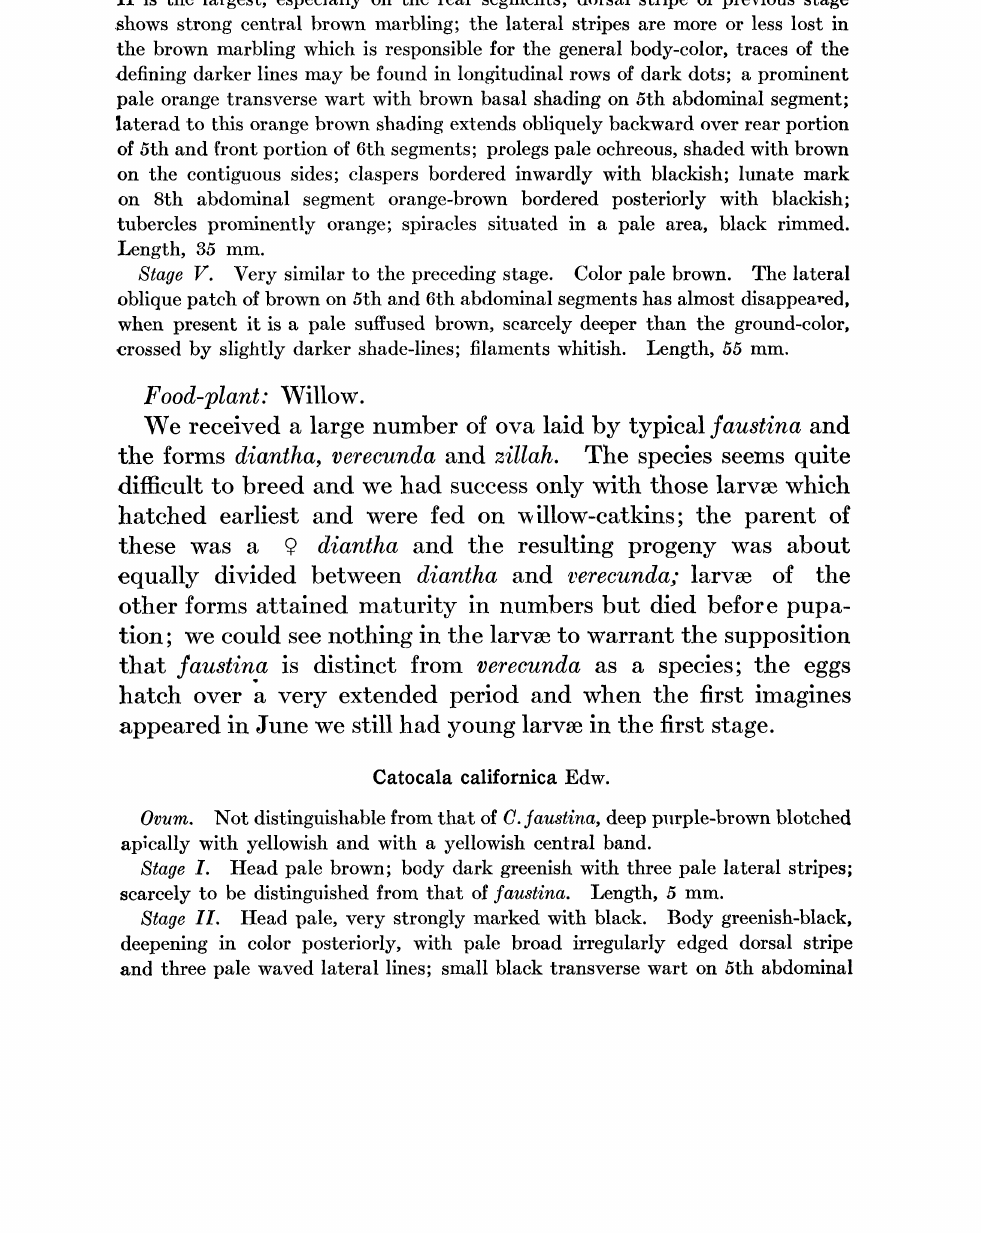
segment with slight central reddish portion; lateral black shading on 5th and 6th abdominal segments extending down over prolegs; a black lunate mark on rear of 8th segment dorsally; tubercles red-brown. Beneath whitish with black patches. Length, 0 mm. Stage IV. Head pale, apex of lobes orange, this color extending downward to the region of the ocelli, the whole frontal area bordered by an encircling black band. Body smooth, slender, pale purple-brown with orange tubercles of which II is the largest, especially on the rear segments; dorsal stripe of previous stage .shows strong central brown marbling; the lateral stripes are more or less lost in the brown marbling which is responsible for the general body-color, traces of the defining darker lines may be found in lontudinal rows of dark dots; a prominent pale orange transverse wart with brown basal shading on 5th abdominal segment; laterad to this orange brown shading extends obliquely backward over rear portion of 5th and front portion of 6th segments; prolegs pale ochreous, shaded with brown on the contiguous sides; claspers bordered inwardly with blackish; lunate mark on 8th abdominal segment orange-brown bordered posteriorly with blackish; tubercles prominently orange; spiracles situated in a pale area, black rimmed. Length, 85 mm. Stage V. Very similar to the preceding stage. Color pale brown. The lateral oblique patch of brown on 5th and 6th abdominal segments has almost disappeared, when present it is a pale suffused brown, scarcely deeper than the ground-color, crossed by slightly darker shade-lines; filaments whitish. Length, 55